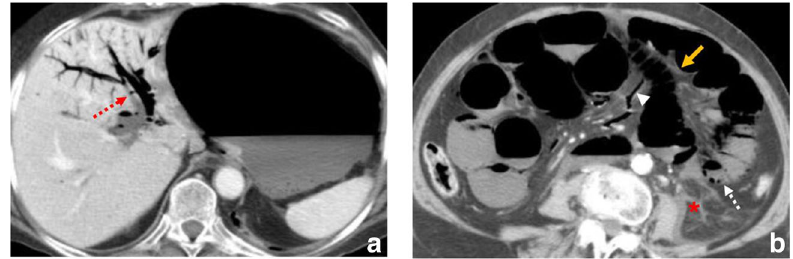
Fig. 5 Contrast-enhanced CT image of the abdomen in an 82-year-old male with embolism of the superior mesenteric artery. ( a ) Contrast- enhanced axial CT shows pronounced intrahepatic portal venous gas (branching hypoattenuating areas) extending into the periphery of the left liver lobe (red arrow). ( b ) Contrast-enhanced axial CTscan shows dilated